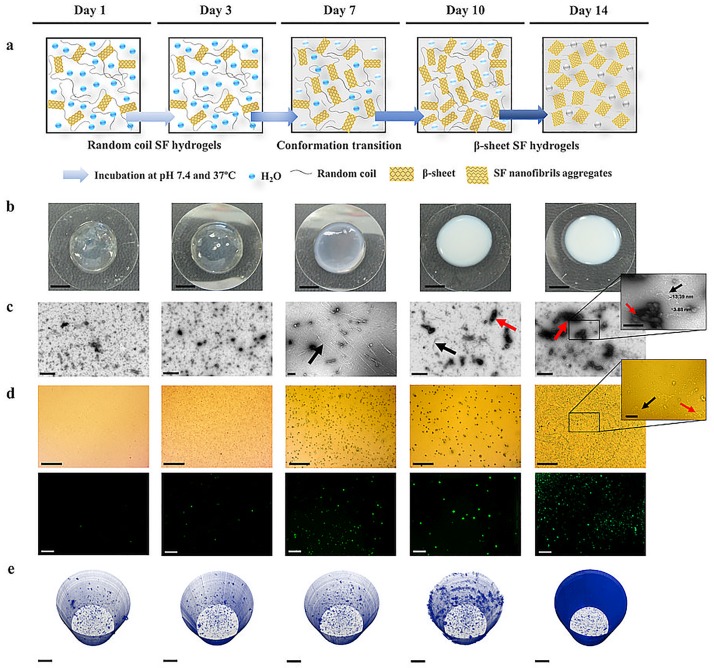
Structural evaluation of the SF hydrogels after incubation in PBS at 37°C for 1, 3, 7, 10 and 14 days.(a) Schematic illustration of the β-sheet structural transitions in the SF hydrogels. (b) Macroscopic images of the SF hydrogels (scale bar, 5 mm). (c) TEM micrographs of the SF hydrogels (scale bar, 500 nm for low magnification images; scale bar, 200 nm for high magnification image). (d) SF hydrogels labeled with thioflavin T (scale bar, 500 μm for low magnification images; scale bar, 100 μm for high magnification image) analyzed under the fluorescence microscope (scale bar, 200 μm). The black arrows indicate nanofibrils and the red arrows indicate aggregates. (e) OPT reconstructions of the SF hydrogels (scale bar, 500 μm). Movies from OPT reconstructions of the SF hydrogels are available in S1–S5 Movies.